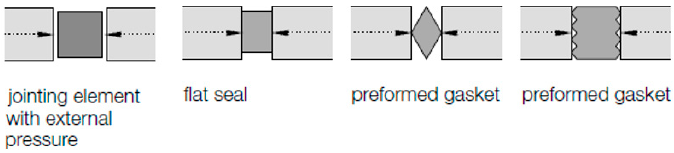
Figure 13. Gasket and jointing element sealing principles [32].